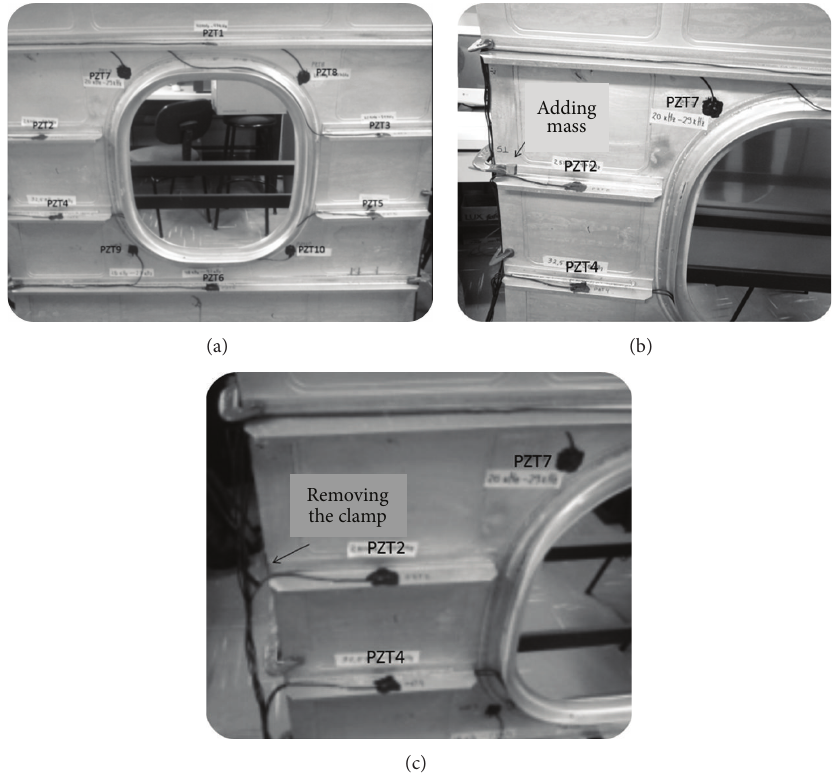
Figure 5: Aluminum aircraft window containing ten PZT